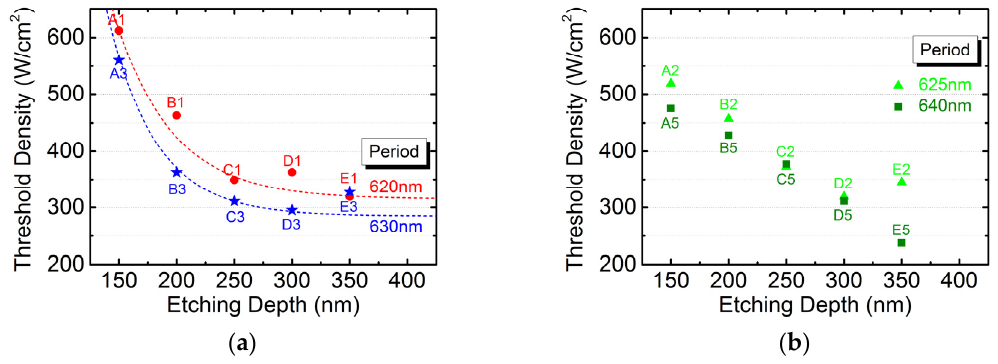
Figure 5. The dependence of threshold power density on the etching depth for ( a ) 620- and 630-nm-period devices (A1 to E1 and A3 to E3) as well as ( b ) 625- and 640-nm-period devices (A2 to E2 and A5 to E5).